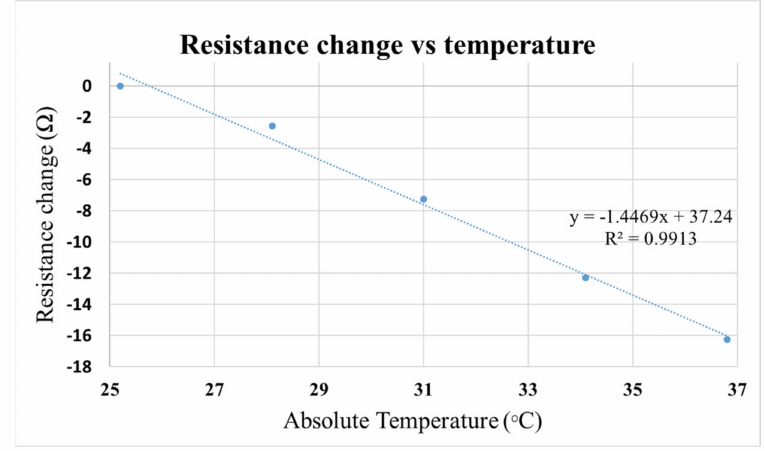
Figure 5. Graph showing the influence of temperature on resistance change of the cell cul- ture